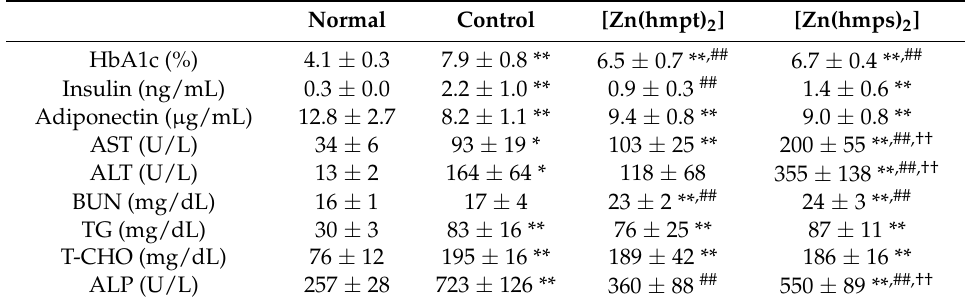
Table 2. HbA1c levels and plasma parameters in normal, control (PEG-400 administered), [Zn(hmpt) 2 ]-treated and [Zn(hmps) 2 ]-treated mice.